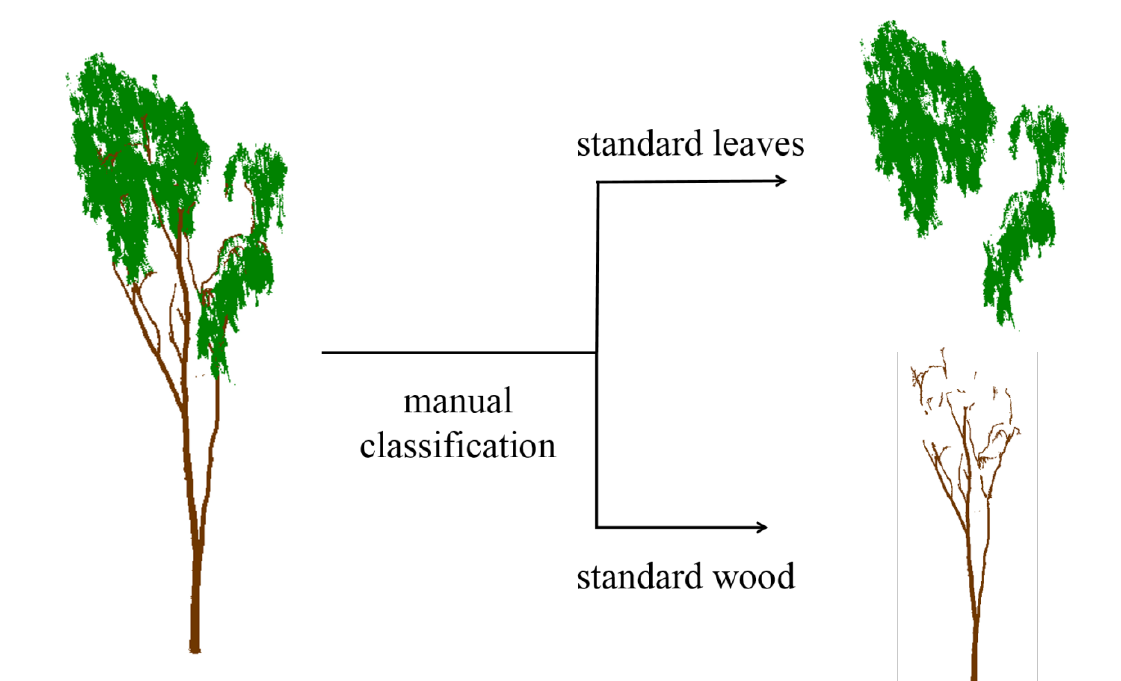
Figure 2. The manual standard classification result of tree 5. Brown: wood points; green: leaf points.